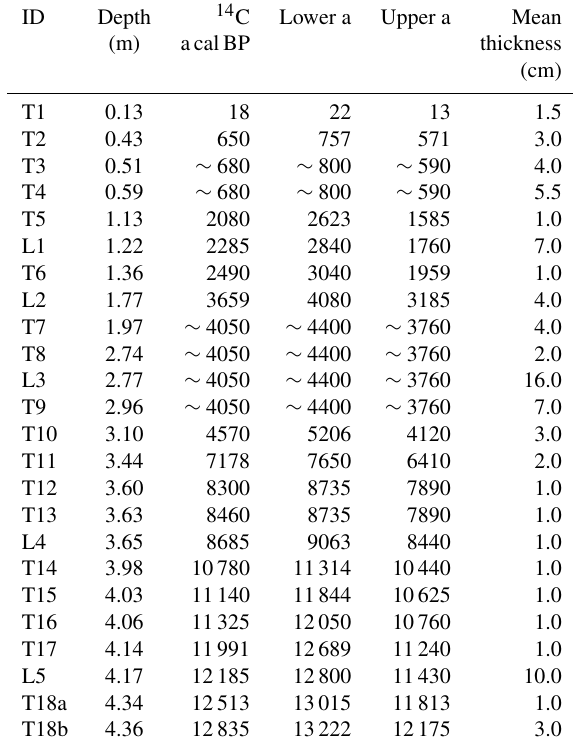
Table 5. Age estimates for LdM